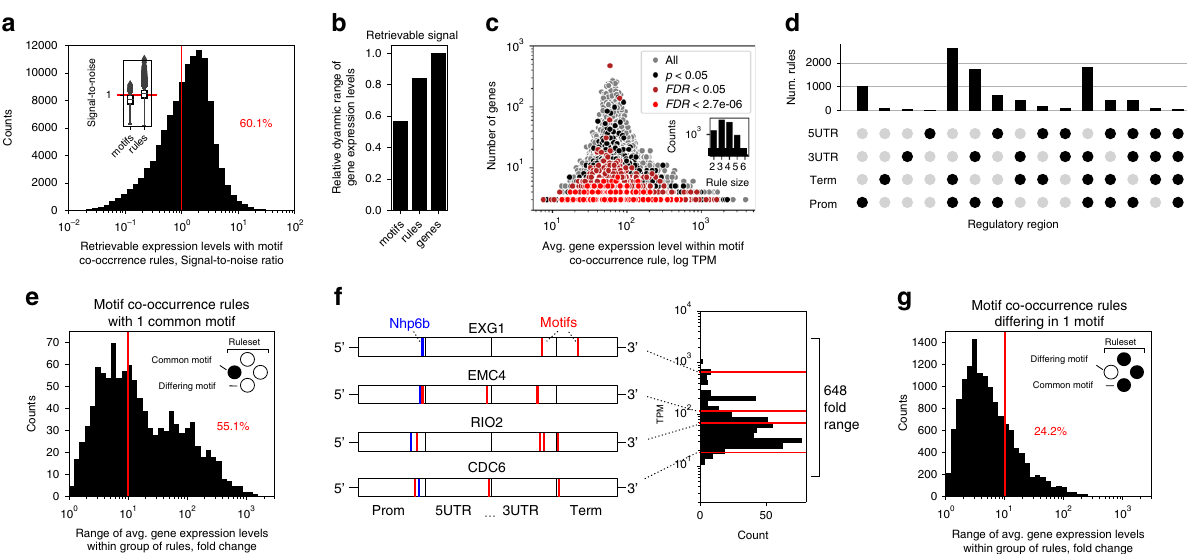
Fig. 4 Motif co-occurrence uncovers the regulatory rules of gene expression. a Distribution of the signal-to-noise ratio ( SNR ) of expression levels across genes carrying co-occurring motifs (co-occurrence rules, see Results text and Methods). Inset: comparison of SNR with single motifs ( n = 2098) and with motif co-occurrence rules ( n = 116,734). b The range of gene expression levels, relative to the full observed range in the initial RNAseq data (~4 orders of magnitude, Fig. 1a), that could be retrieved on average by genes carrying either single motifs or motif co-occurrence rules. c The amount of genes carrying a given motif co-occurrence rule versus the average expression level across the set of genes carrying the given rule, with increasing statistical signi fi cance levels from a chi-squared test 76 . FDR denotes Benjamini-Hochberg (BH) adjusted p -value and data is colored gray except for signi fi cance cutoffs p < 0.05 (black), FDR < 0.05 (dark red) and FDR < 2.7e-6 (equals Bonferroni correction, red). Inset: distribution of the number of co-occurring motifs in signi fi cant (FDR < 0.05) rules. d Distribution of motif co-occurrence rules across single or multiple cis -regulatory regions, according to the locations of the co- occurring motifs. e Distribution of gene expression levels with groups of motif co-occurrence rules that have one motif in common (i.e. unchanged). f Illustration of four genes ( CDC6 , RIO2 , NSP1 , EXG1 ) that carry a group of motif co-occurrence rules with a common motif (NHP6B transcription factor binding site, Tomtom 67 BH adj. p -value < 0.005, SGD:S000002157 104 , blue line) in their promoter region, whereas they all diverge in possessing 2 to 4 other DNA motifs (red lines) across the remaining regulatory regions. These genes span a 648-fold range of expression levels. Red lines in the histogram denote the speci fi c expression levels of the genes. g Distribution of gene expression levels with groups of motif co-occurrence rules that differ by a single motif. Source data are provided as a Source data fi